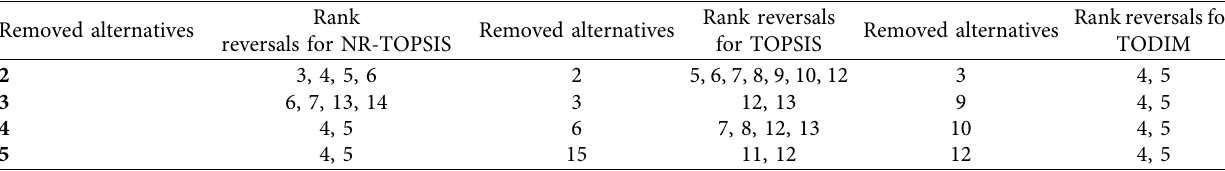
Table 15: Comparison of rank reversal results of NR-TOPSIS, TOPSIS, and TODIM when one alternative is removed from the original rank list of batsmen.